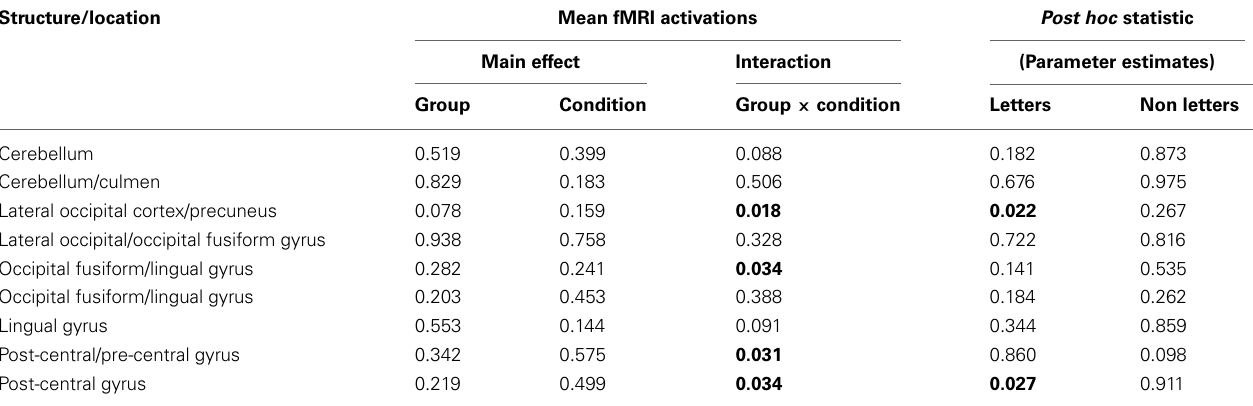
Table 4 | ROI analysis for fMRI conditions using gray matter VBM defined